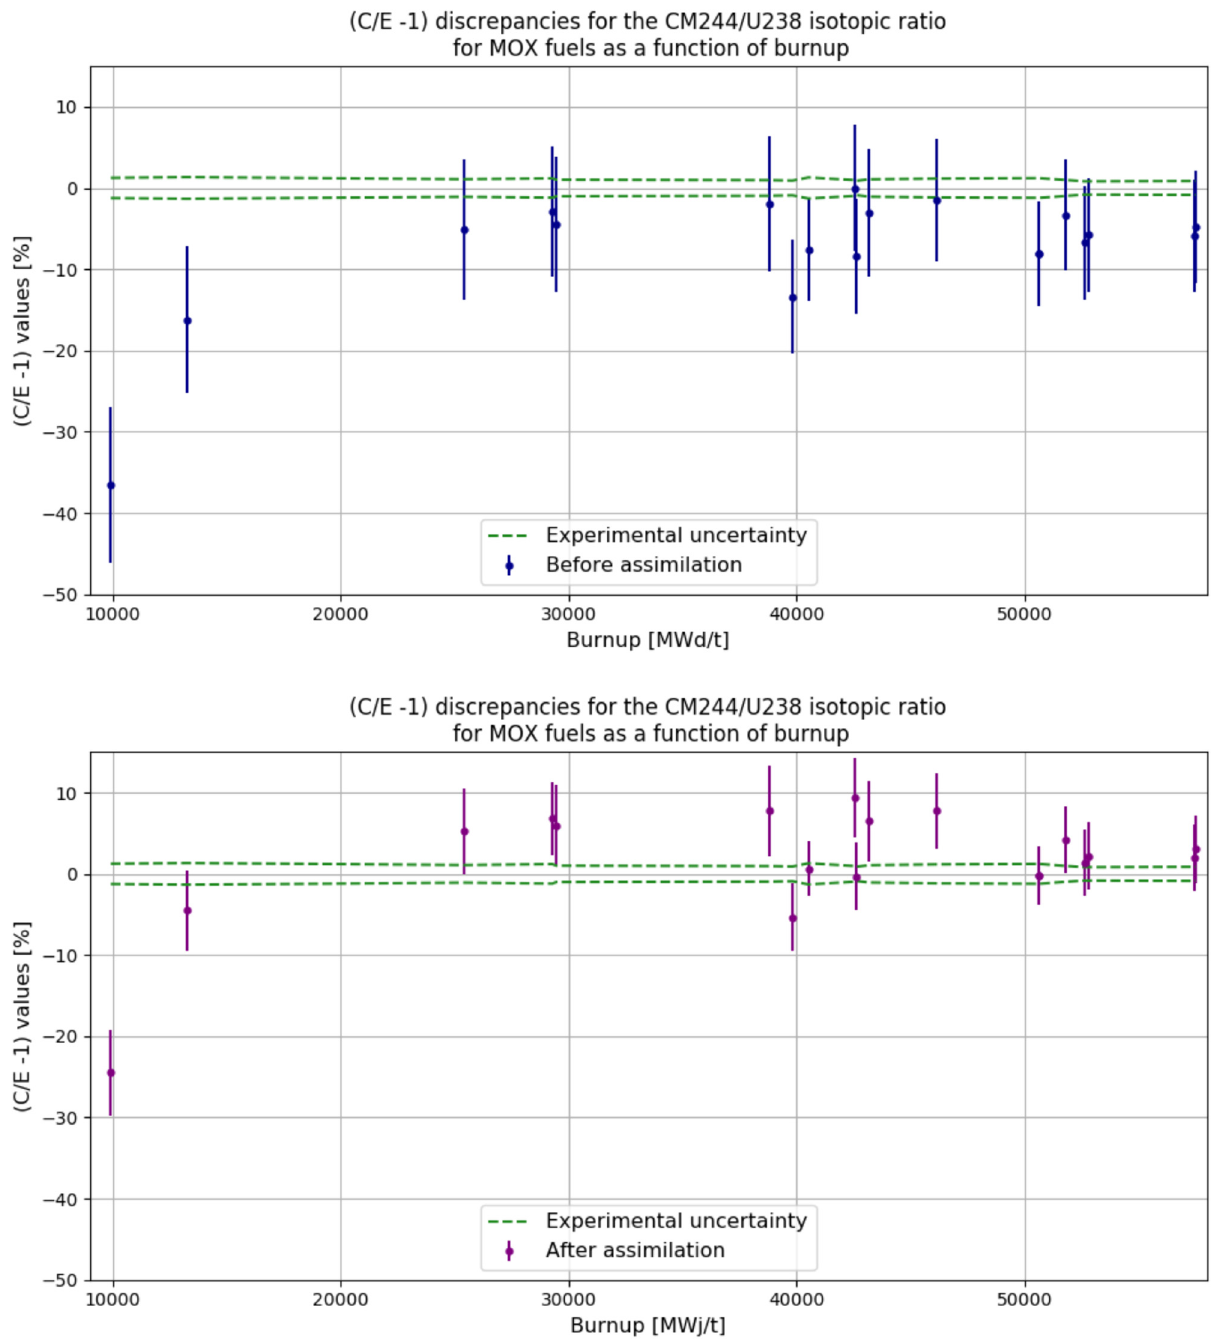
Fig. 9. Evolution of the calculated-to-experimental discrepancies before and after integral data assimilation for the 244 Cm/ 238 U isotopic ratio in MOX